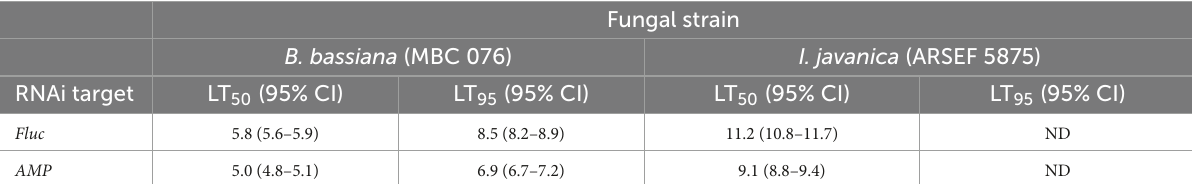
TABLE 1 Estimated LT 50 and LT 95 values from B. bassiana and I. javanica -infected mosquitoes in which Fluc (control) or four antimicrobial peptide transcripts were depleted via